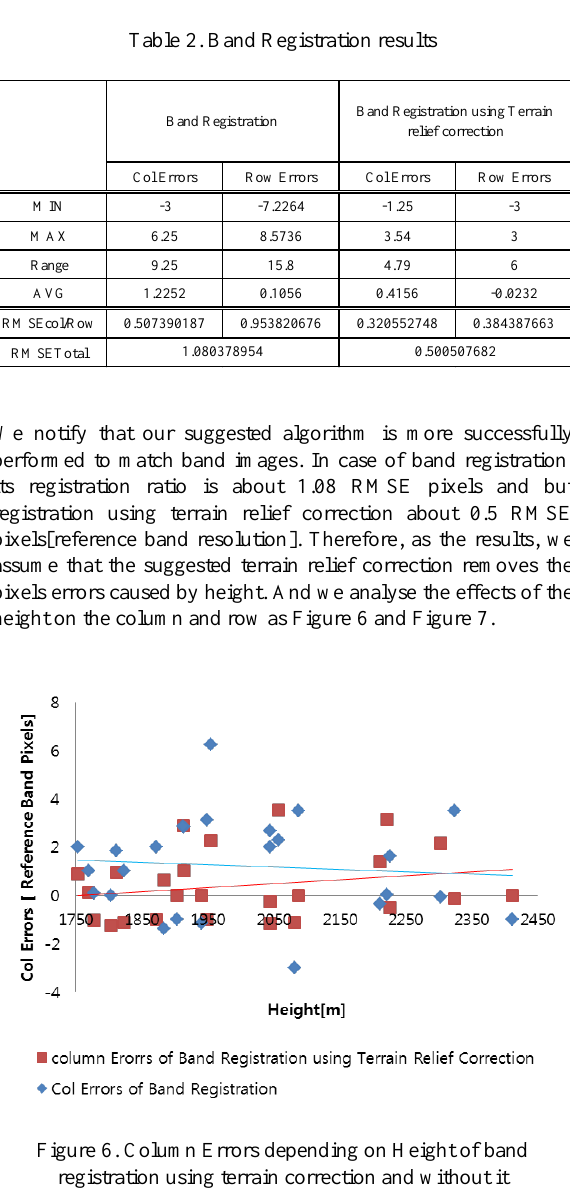
Figure 5. the distribution of 25 GCPs in Google earth